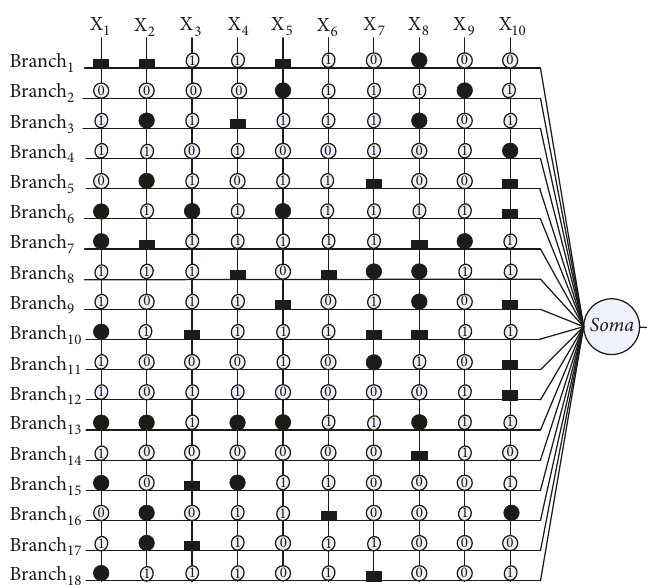
Figure 12: The dendritic morphology of the Distress data set after